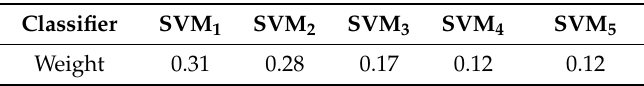
Table 7. Voting weights of the classifiers for the recognition of adults, dogs and geese in the outdoor environment.